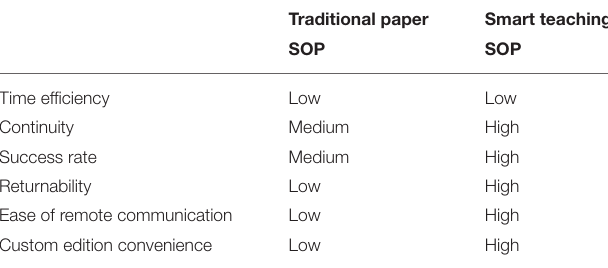
TABLE 4 | Comparison between traditional paper version and this research